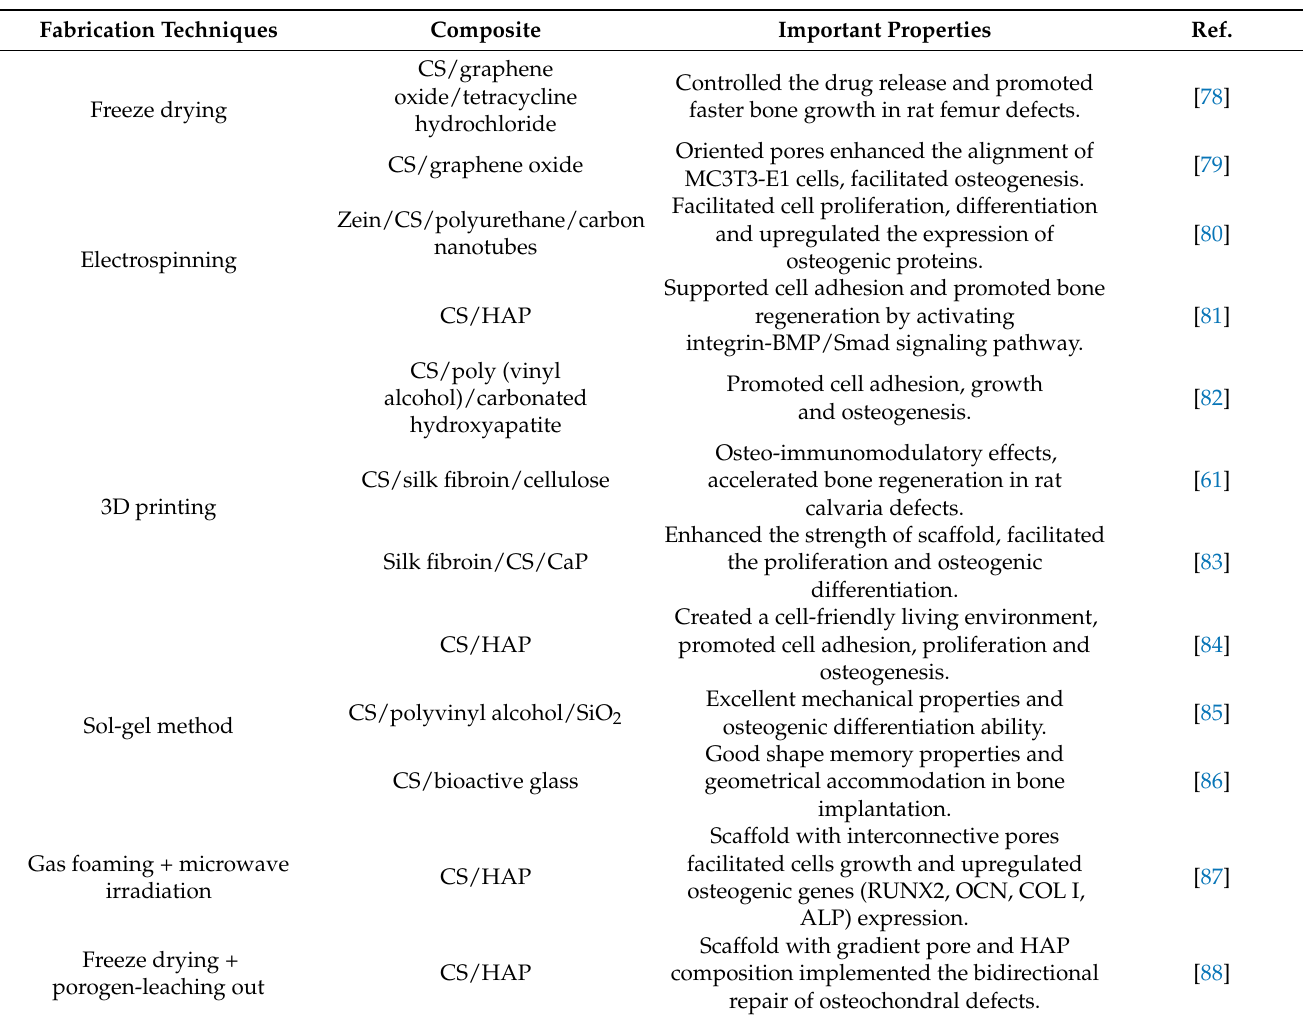
Table 1. The fabrication techniques and properties of CS-based